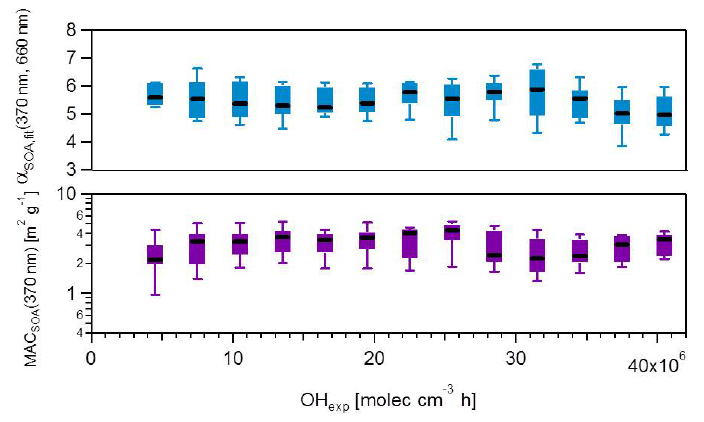
Figure 5. MAC SOA (370nm) and α SOA , fit (370, 660nm) calculated from several smog chamber experiments plotted as a function of OH exposure. The boxes mark the 25th and 75th percentiles, while the whiskers mark the 10th and the 90th percentiles. MAC SOA (370nm) was obtained using Eq. (19). α SOA , fit (370, 660nm) was obtained from fitting the MAC SOA values in the range 370–660nm for the different experiments against the wavelength. α SOA , fit (370, 660nm) is the slope of the linear fit applied after log transforming the data. MAC SOA (λ) for higher wavelengths are shown in Fig. S10.